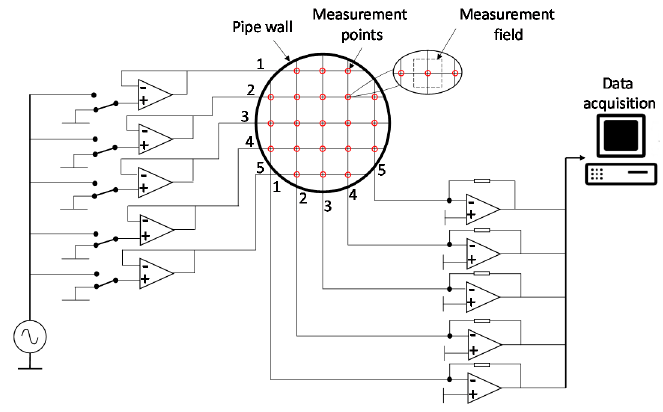
Figure 3. Scheme of a wire-mesh sensor with 5 × 5 electrodes.